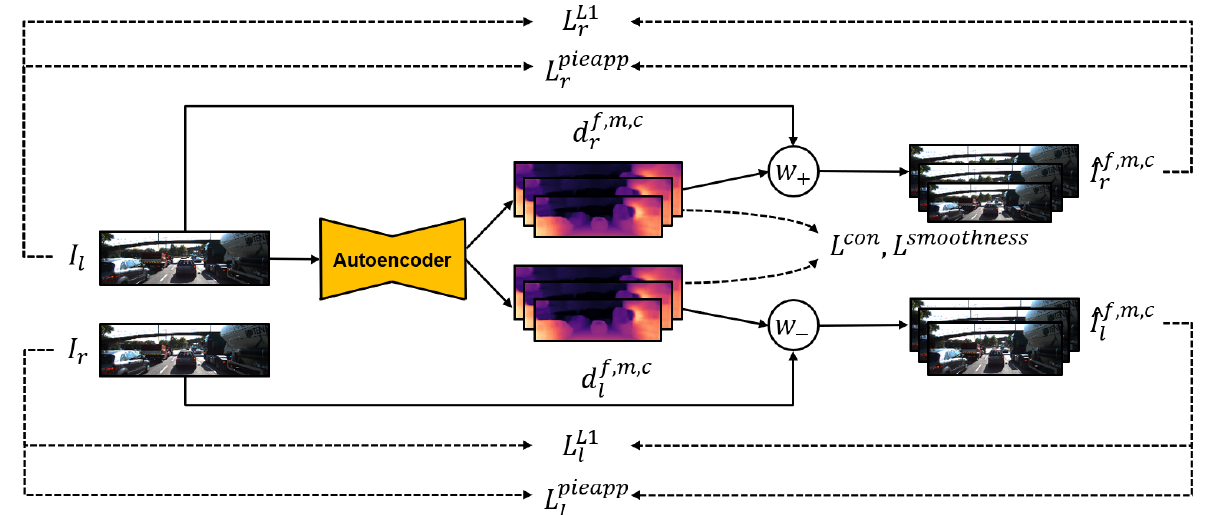
Figure 1. Illustration of the detailed framework and loss functions for the proposed unsupervised depth-estimation model. ( I l : left image, I r : right image, d l : disparity map to warp left, d r : disparity map to warp right, w + : warping right, w − : warping left, ˆ I l : reconstructed left image, ˆ I r : reconstructed right image, L L 1 : L1 loss between the reconstructed and target images, L pieapp : PieAPP loss between the reconstructed and target images, L con : left–right consistency loss, L smooothness : smoothness